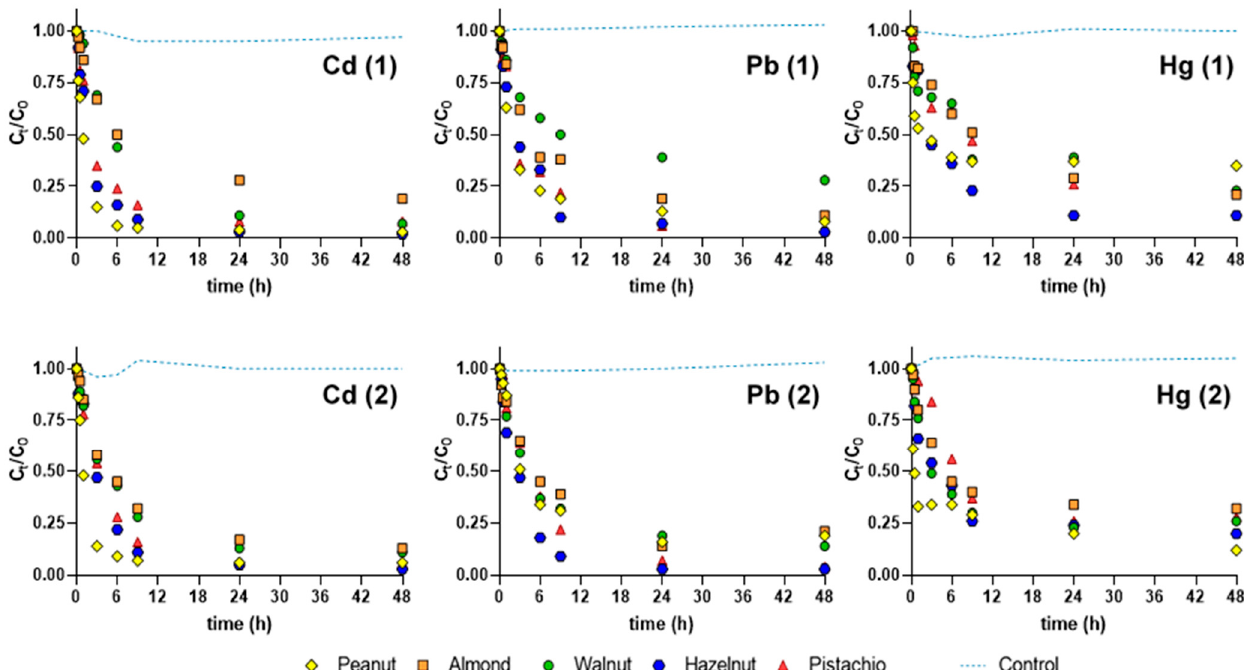
Figure 2. Normalized concentration ( C t /C 0 ) of cadmium (Cd), lead (Pb), and mercury (Hg) in ultrapure water spiked with initial concentrations of (1) 2 µmol L − 1 and (2) 200 µg L − 1 of Cd, 1000 µg L − 1 of Pb, and 50 µg L − 1 of Hg. Standard deviation bars (always ≤ 5%) were omitted for clarity. Table 2. Quantity of cadmium (Cd), lead (Pb), and mercury (Hg) sorbed per unit of mass onto the biosorbents surface (q, µ g g − 1 ) and respective percentage of removal (%) relative to the initial concentration.